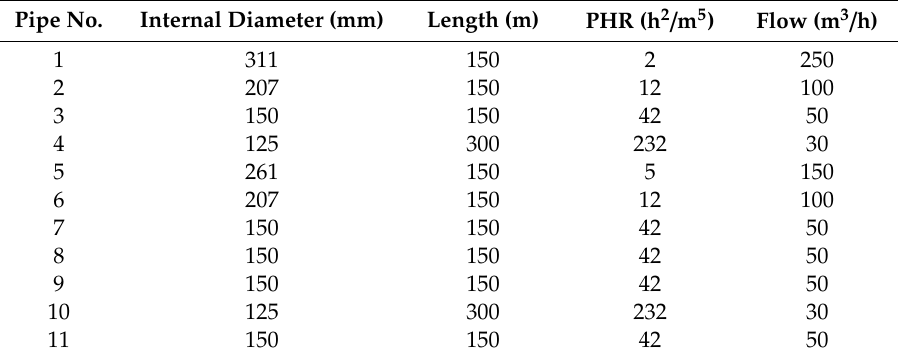
Figure 1. Schematic diagram of an example branch district heating network (DHN). Table 1. Pipes information of the example branch DHN.